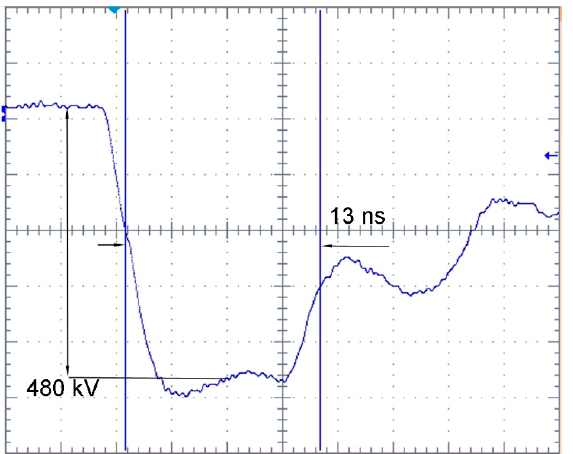
Figure 11. Voltage waveform at the resistive load for single PFL charged to − 600 kV (time base 4 ns/div).